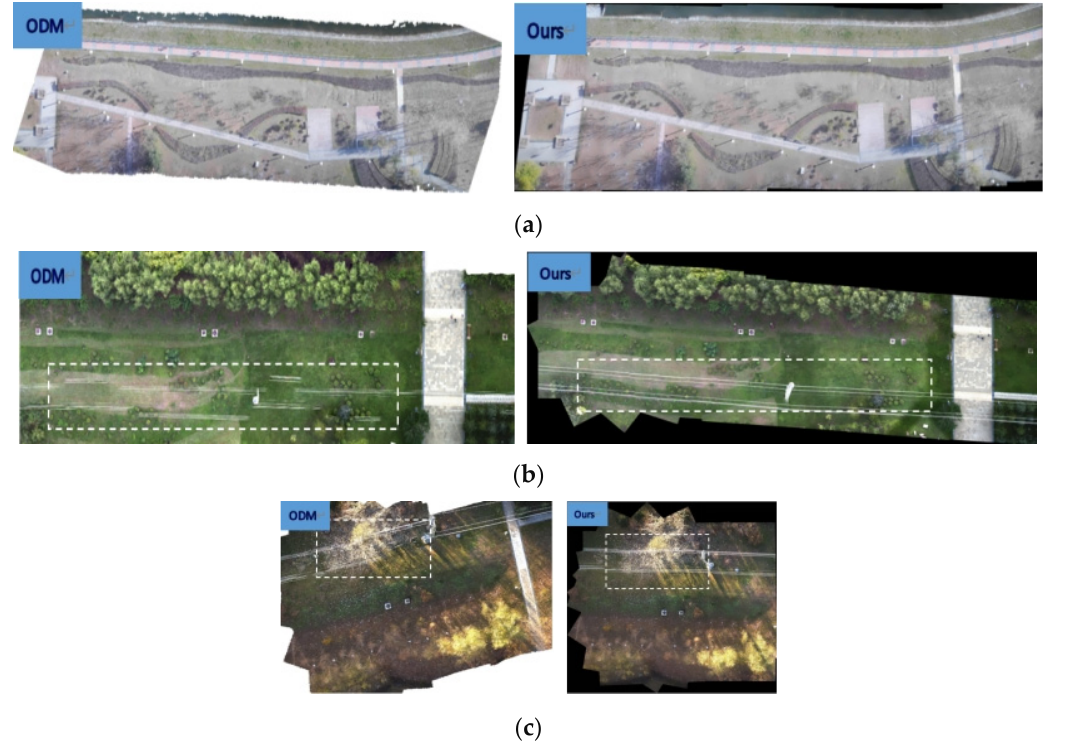
Figure 6. Panoramas of ODM method and our method on real color aerial dataset. ( a ) Panoramas for ODM and ours on spring aerial images; ( b ) Panoramas for ODM and ours on summer aerial images; ( c ) Panoramas for ODM and ours on autumn aerial images.